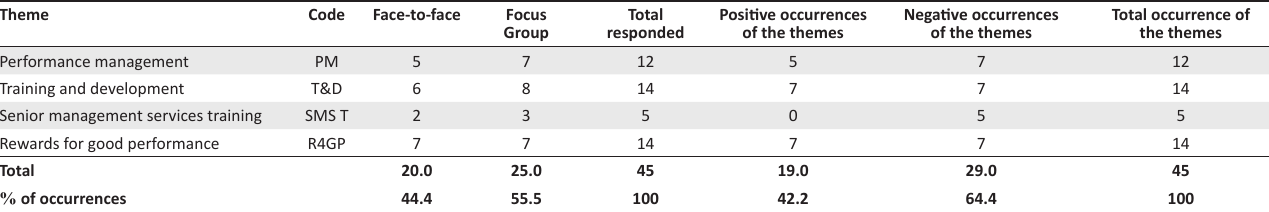
TABLE 6: Quantified qualitative outcomes of themes for Cluster 1: Performance